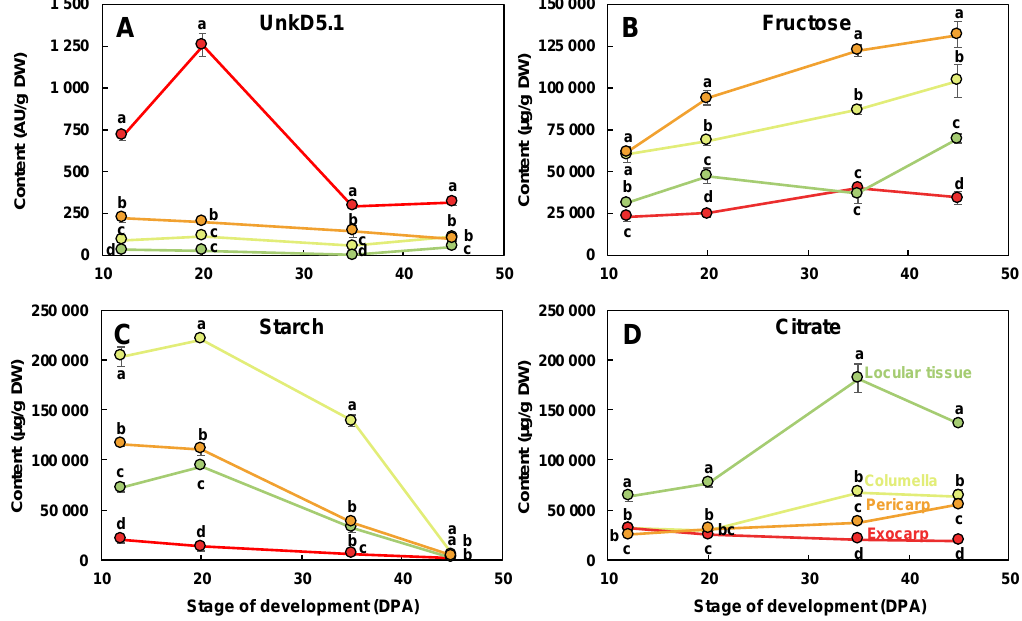
Figure 7. Changes of representative compounds in each of the four studied fruit tissues. ( A ) UnkD5.1 and ( B ) fructose measured using 1 H-NMR, ( C ) starch measured using enzymatic analysis, and ( D ) citrate measured using 1 H-NMR in the dissected tissues during tomato fruit development and expressed on a dry weight (DW) basis. Exocarp in red, mesocarp with endocarp in orange, columella with placenta in yellow, and locular tissue in light green. Mean ± SD of 3 replicates per stage. Vertical bars represent SD. For each stage, means accompanied by the same letter were not significantly different (Tukey’s studentized test, P < 0.05). AU, arbitrary units.